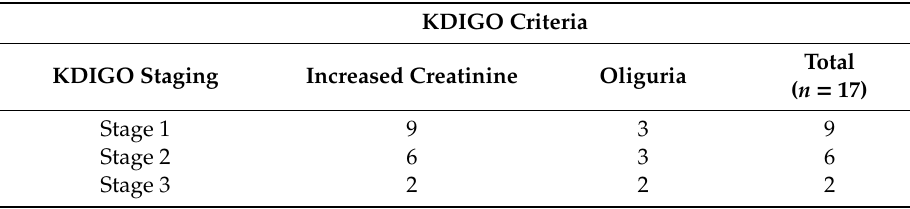
Table 2. Characteristics of AKI